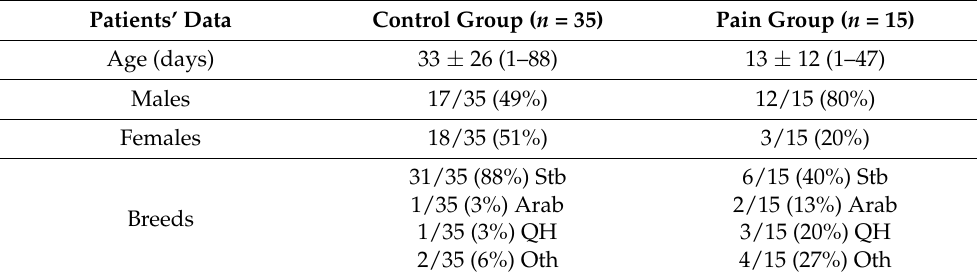
Table 1. Demographic details of the 50 foals used in the study. Categorical data are expressed as absolute values and percentage (%) while foals’ age is expressed as mean ± standard deviation (min–max